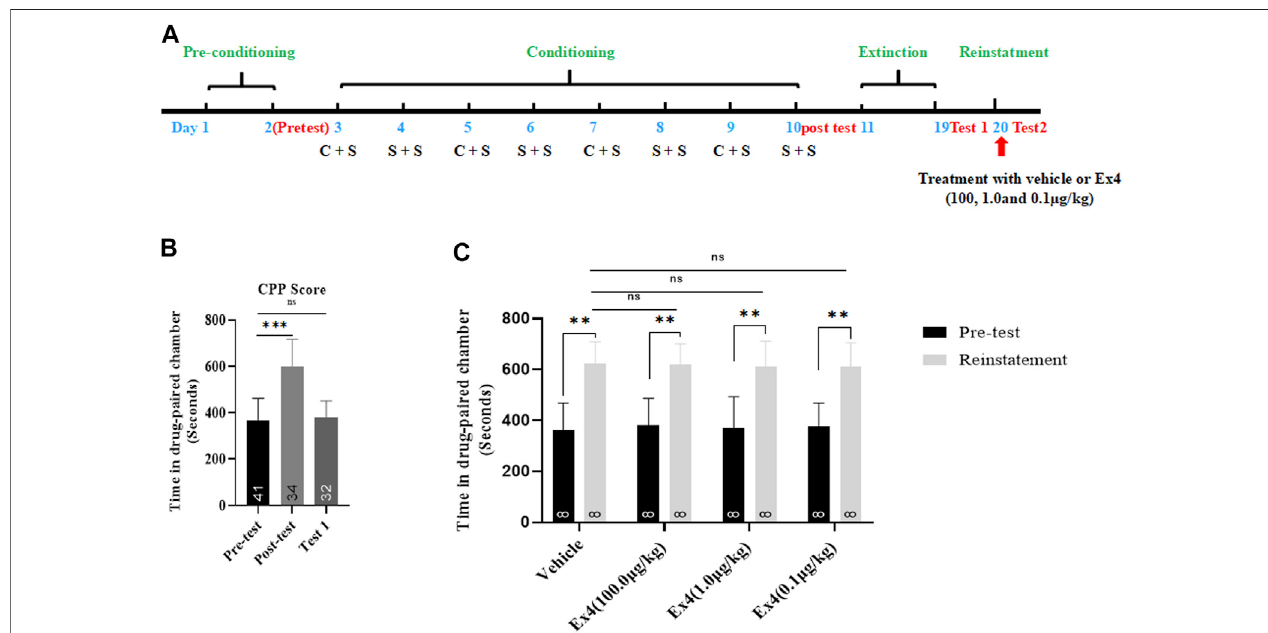
FIGURE 4 | Ex4 ’ s single treatment does not attenuate reinstatement of cocaine-induced CPP. (A) The experimental schedule for saline (S) as well as cocaine (C) and Ex4treatments. (B) CPP scoresfollowing cocaine conditioning and extinction show that compared tothe pretest cocaine treated mice ( n (cid:2) 34) induced asigni fi cant CPP,whichwasextinguishedbyextinctiontraining.***represents p < 0.001vspretest,nsrepresentsnosigni fi cantdifference,Student ’ st-test. (C) CPPscoresfollowing an acute single treatment with vehicle and Ex4 (100, 1.0, and 0.1 μ g/kg) on the reinstatement day show that animals treated with Ex4 ( n (cid:2) 8) have no signi fi cant effects on preventing cocaine-triggered reinstatement compare to vehicle ( n (cid:2) 8). ** represents p < 0.01 vs pretest, paired t-test. ns represents no signi fi cant difference, one-way ANOVA followed by a Dunnett ’ s post hoc test. All data are presented as the mean ±